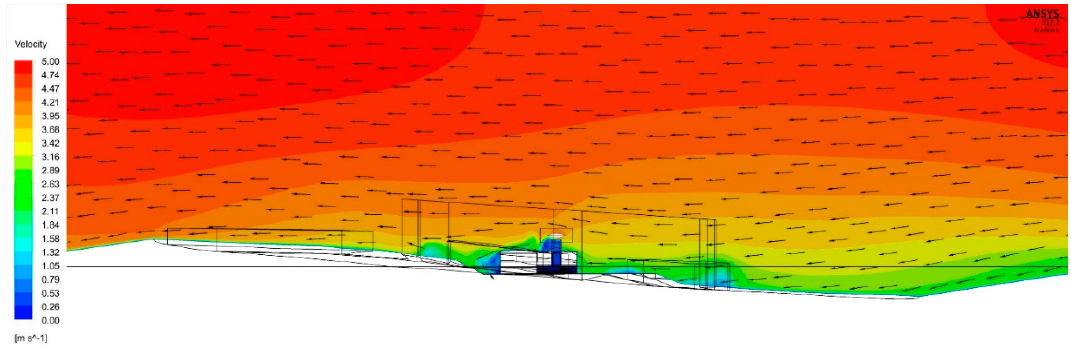
Figure 11. Air flow field in the CFD simulation model, velocity contours and vectors (m/s).